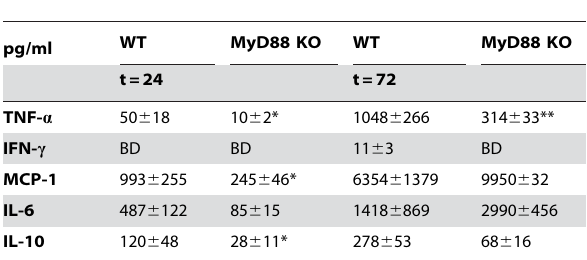
Table 1. Role of MyD88 in B. pseudomallei induced pulmonary cytokine